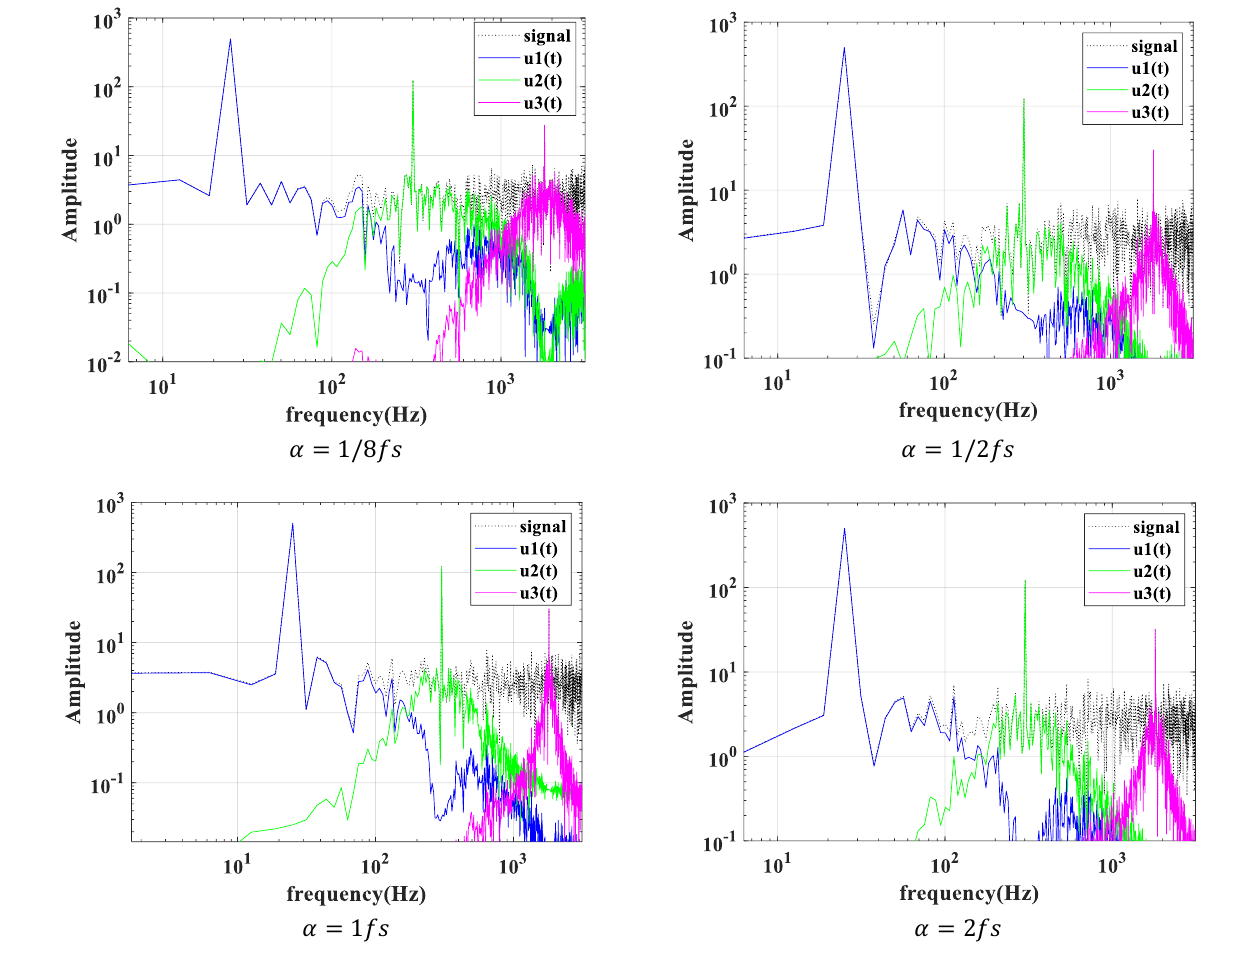
Figure 3. 𝛼 = 1/8𝑓𝑠, 1/2𝑓𝑠, 𝑓𝑠, 2𝑓𝑠 modal signal spectrum